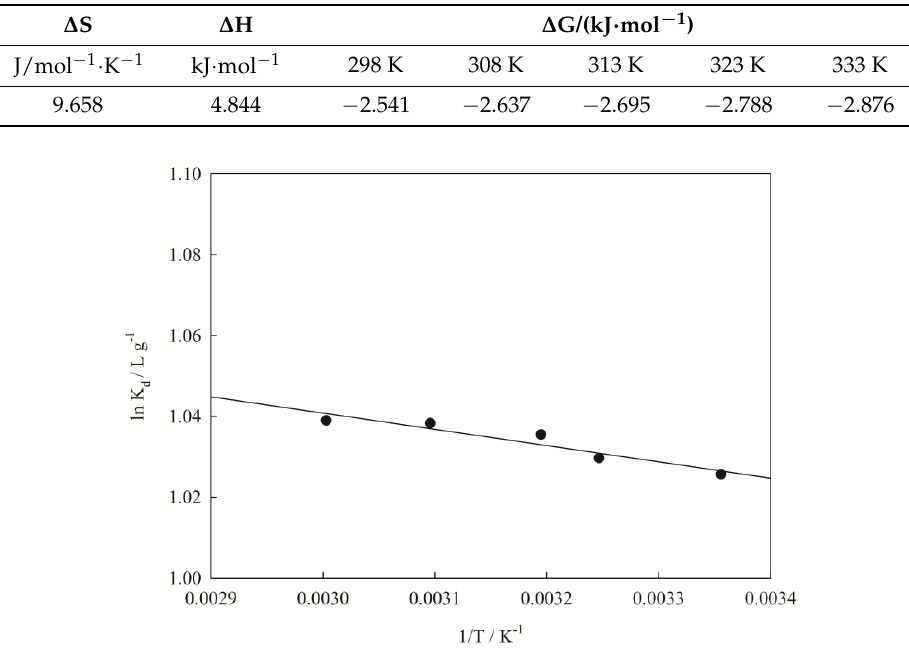
Figure 6. Relationship between 1/T and ln K d for nano I-S m .